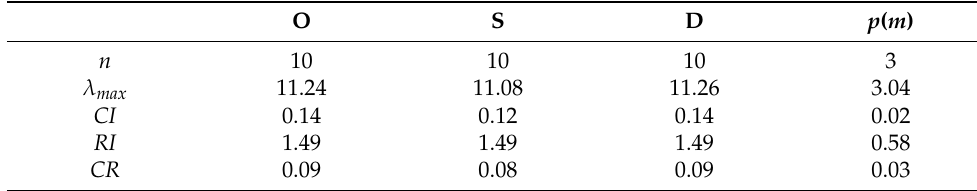
Table A8. Results of consistency